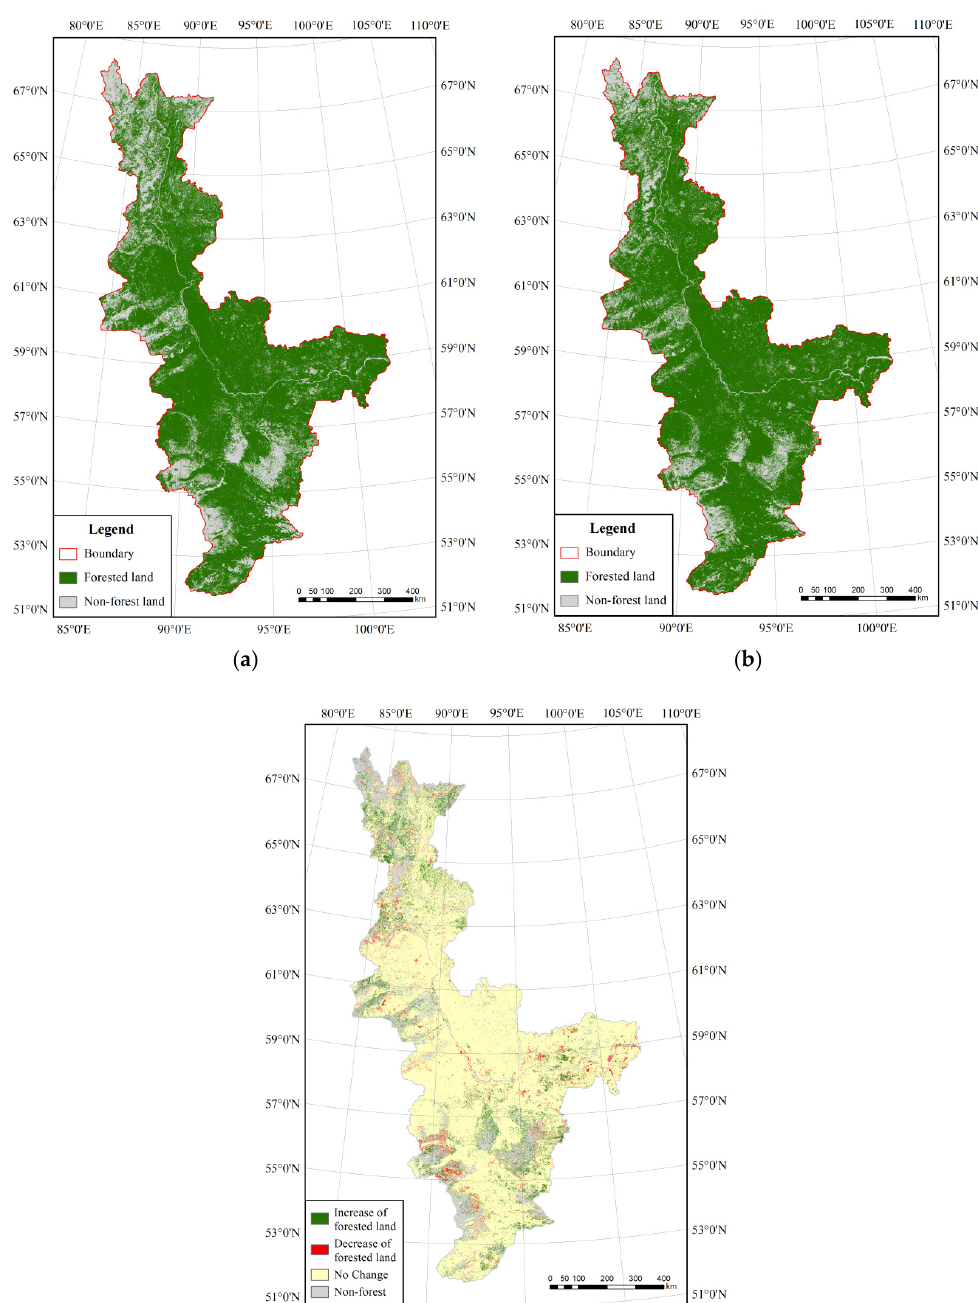
Figure 5. Forest and nonforest land classification: ( a ) in 1985; ( b ) in 2015; ( c ) the spatial change of the forest and nonforest lands.